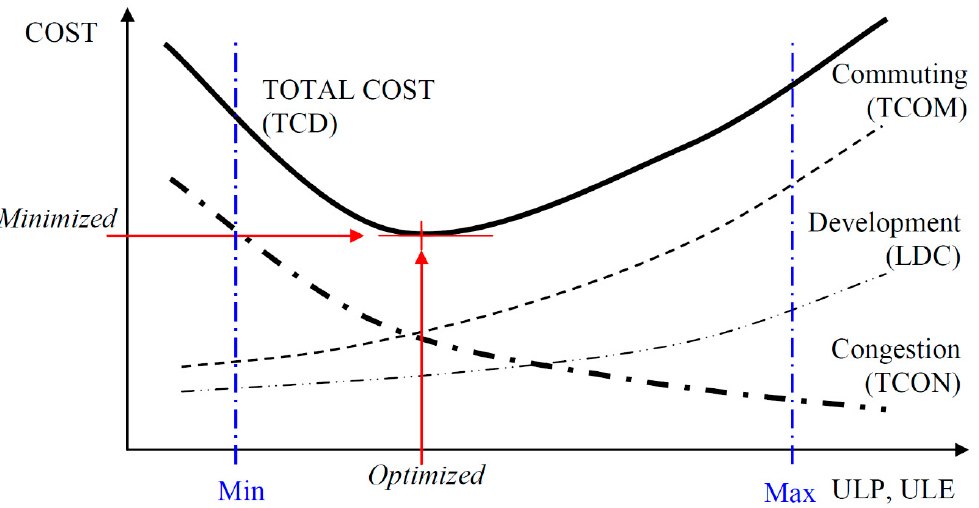
Figure 5. Commuting Cost, Land Development Cost, Congestion Cost, and Optimal Density.